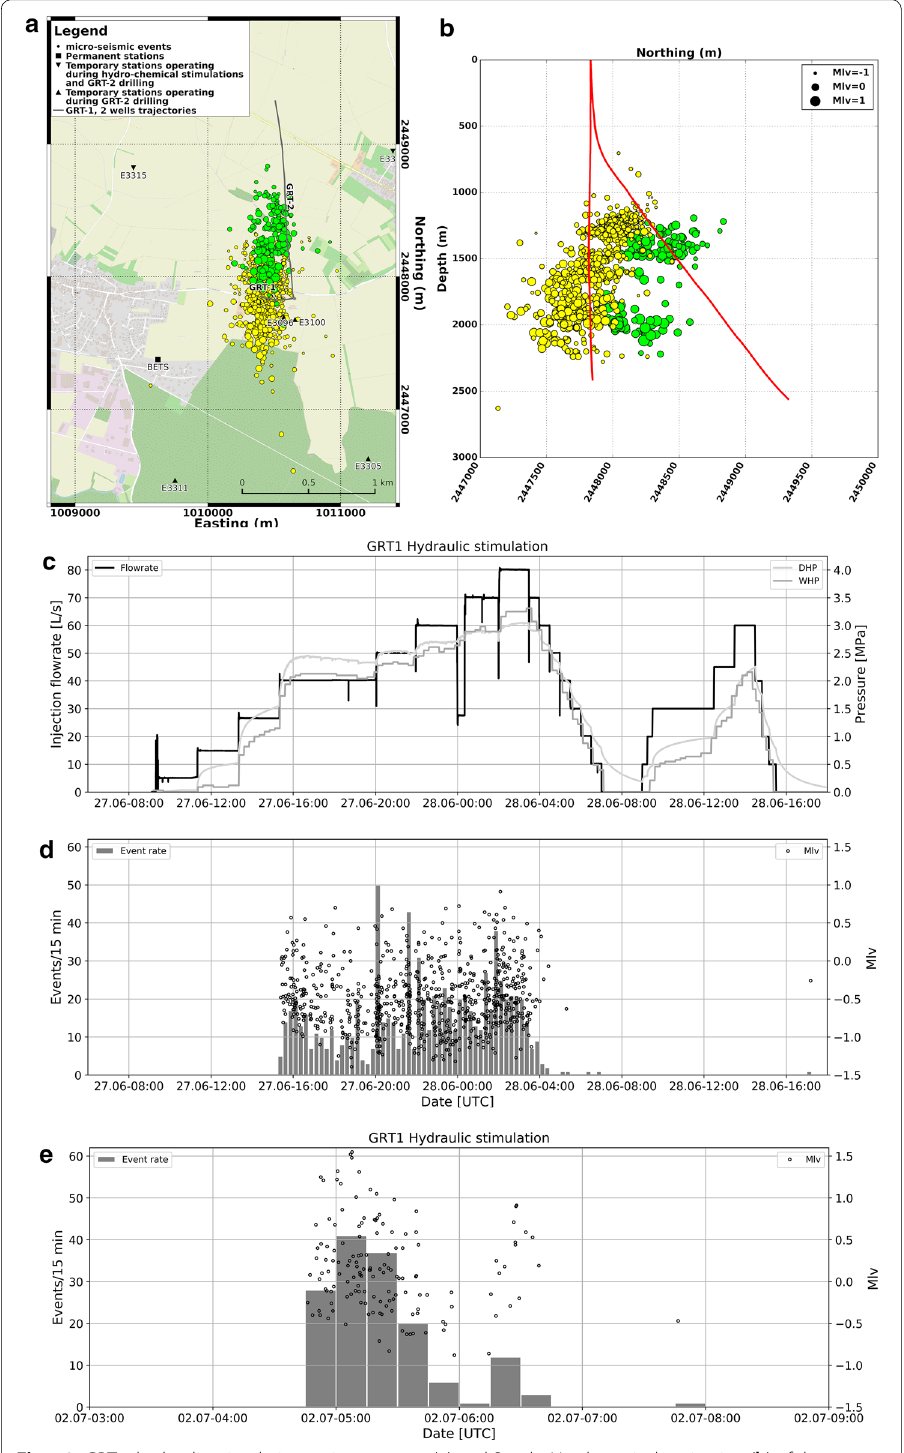
Fig. 10 GRT-1 hydraulic stimulation: epicenter map ( a ) and South–North vertical projection ( b ) of the seismicity recorded during GRT-1 hydraulic stimulation (yellow circles), including the following crisis of July (green circles); injection flow rate, wellhead pressure and downhole overpressure over time ( c ) in parallel with the seismic rate per 15 min and the local magnitude ( d ); seismic rate per 15 min and local magnitude of the earthquakes recorded during the July crisis while no injection operation was on-going ( e